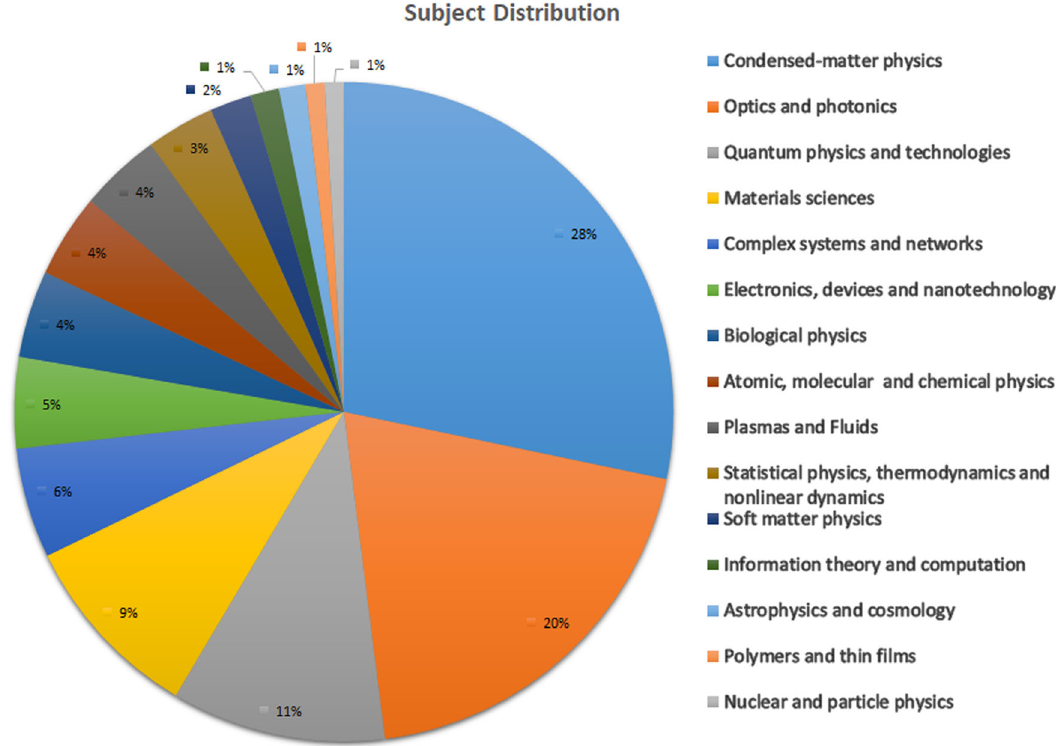
Fig. 1 Subject distribution. Sub fi elds of physics published in Communications Physics between February 2018 and February